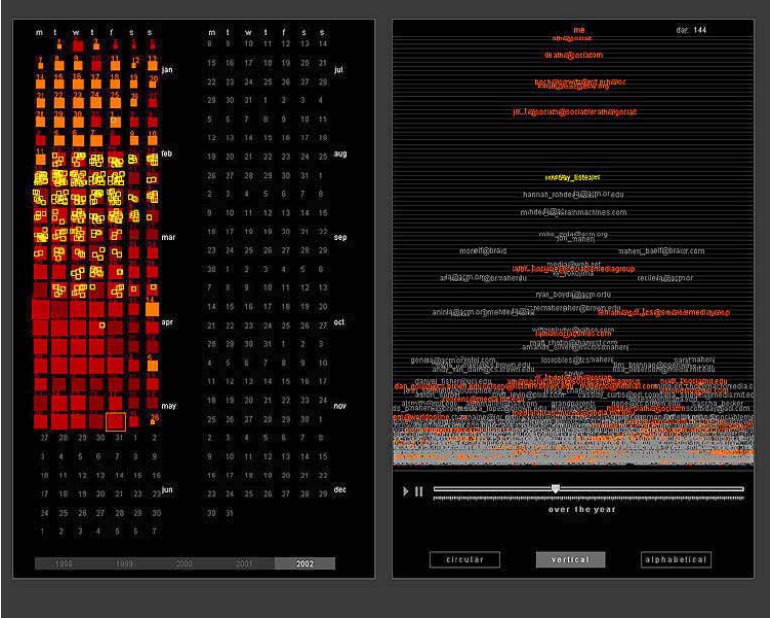
Figure 15. Viegas et al. show the PostHistory visualisation. On the left is the calendar view, showing 365 squares to represent each day of the year (This image only shows data up until May). Size corresponds to the volume of email sent on that day. The colour highlights a specific recipient that has been selected in the contact panel ( left ). The contact panel shows all the contacts the user has been corresponding with over the year. A contact can be selected to highlight their interaction in the calendar view [36]. Image courtesy of Viegas et al.